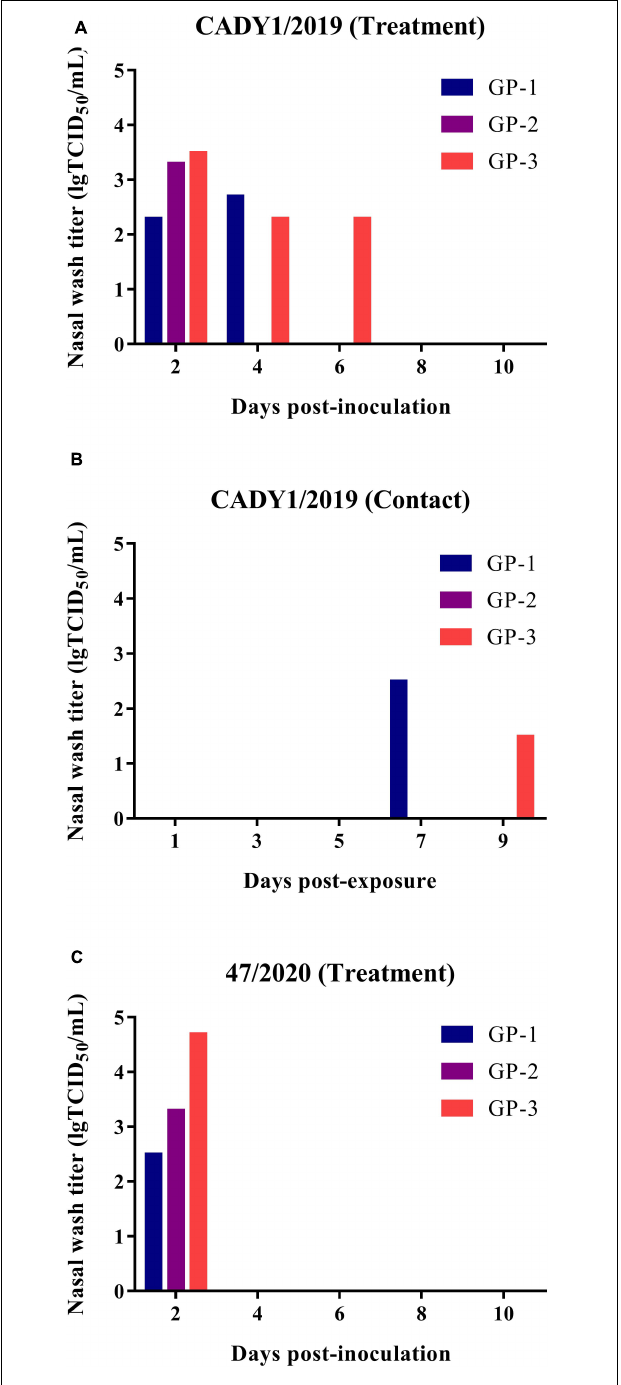
FIGURE 6 | Replication and transmission of viruses in guinea pigs. Six guinea pigs were inoculated intranasally at a dose of 10 6 TCID 50 of CADY1/2019 or 47/2020 in 300 µ L and were then co-housed with three naïve guinea pigs at 1 dpi. Three guinea pigs were intranasally inoculated with 300 µ L PBS as control group. The nasal washes of the guinea pigs were collected at 2, 4, 6, 8, 10 dpi for virus titration in MDCK cells. The sera of guinea pigs were collected at 21 dpi for HI titers detection. (A) The nasal wash titers of CADY1/2019 treatment group. (B) The nasal wash titers of CADY1/2019 contact group. (C) The nasal wash titers of 47/2020 treatment